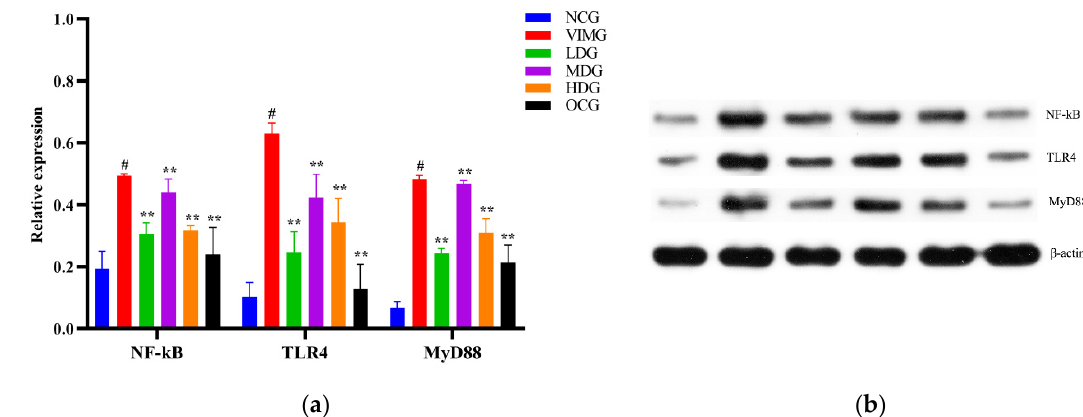
Figure 5. Relative expression of TLR4, MyD88 and NF- к B proteins versus β -actin in MDCK cells ( a ); Detected expression of TLR4, MyD88, NF- к B and β -actin proteins in MDCK cells using Western-blotting assay ( b ). Comparison with virus infection model group (VIMG), ** p < 0.01. Comparison with the negative control group (NCG), # p < 0.01. Data were means ± SD of three independent experiments.